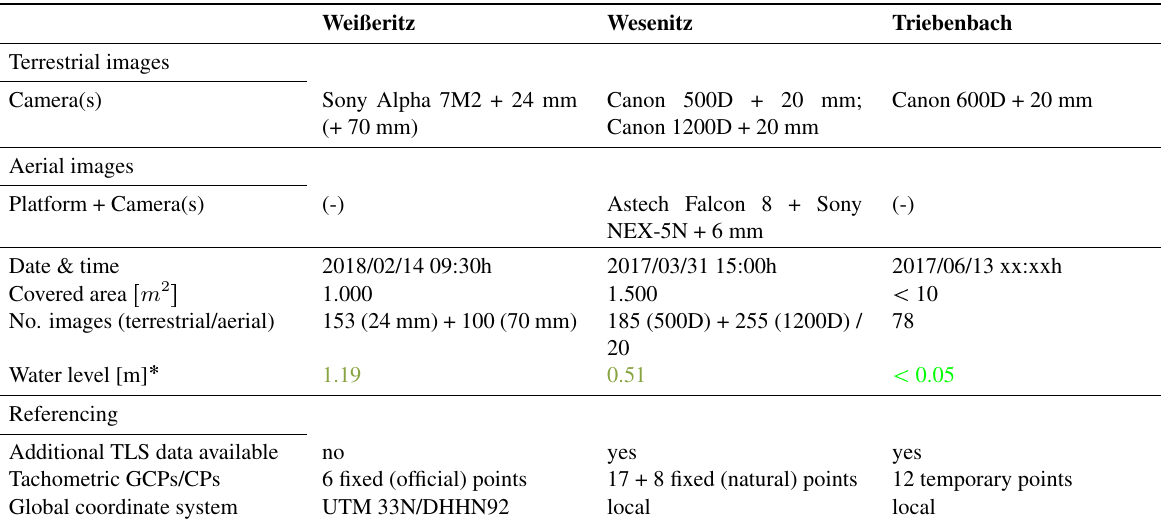
Table 2. Generation of base topography by application of